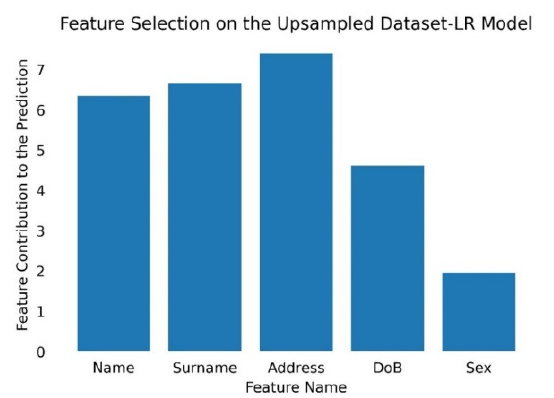
Figure 7. Feature importance of the LR model using the up-sampled dataset as input.